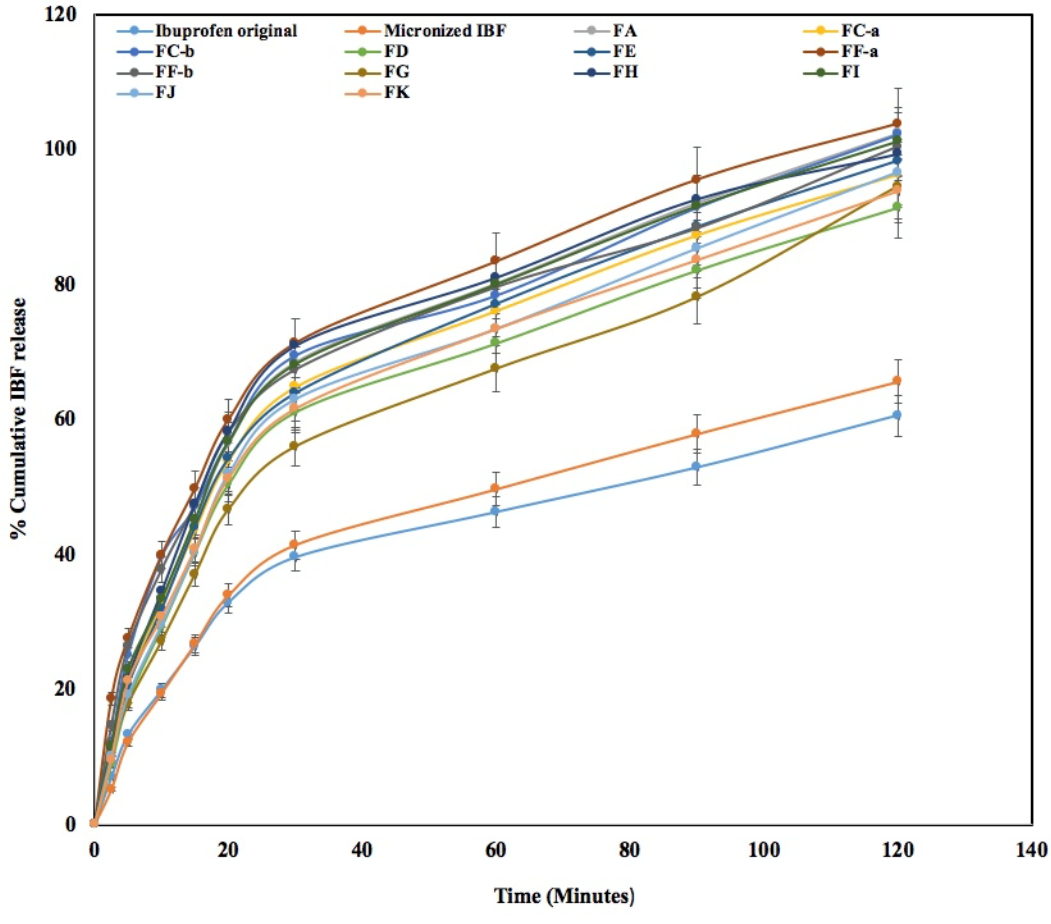
Figure 7. In vitro drug release of original, micronized and DPI formulations by Dissolution study (Mean ± SD, n = 3).